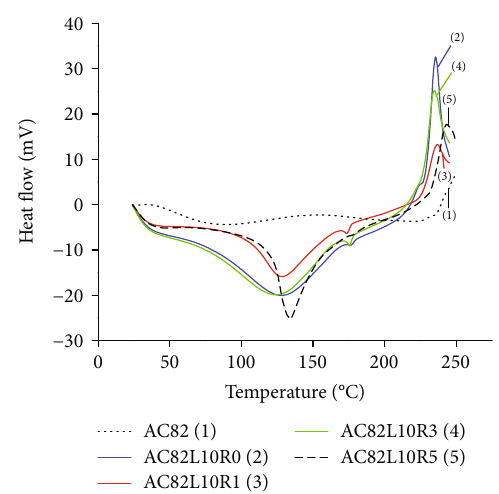
Figure 3: DSC diagrams of AC82L10R x composite fi lms.